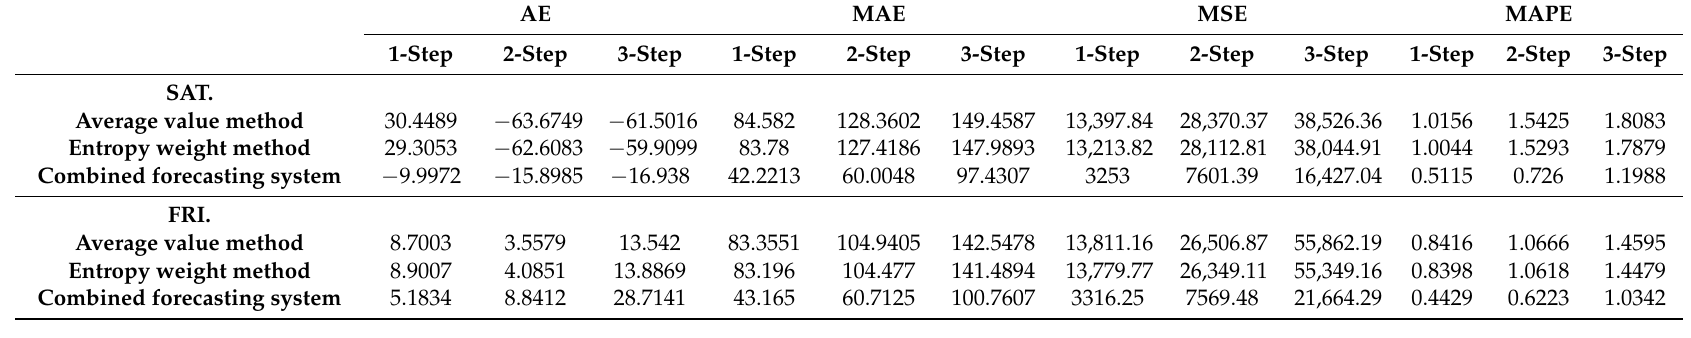
Table 12. Comparison between the proposed combined forecasting system and linear combined models.